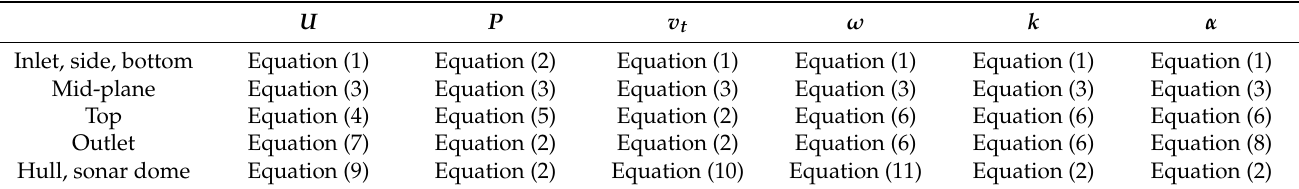
Table 1. Boundary